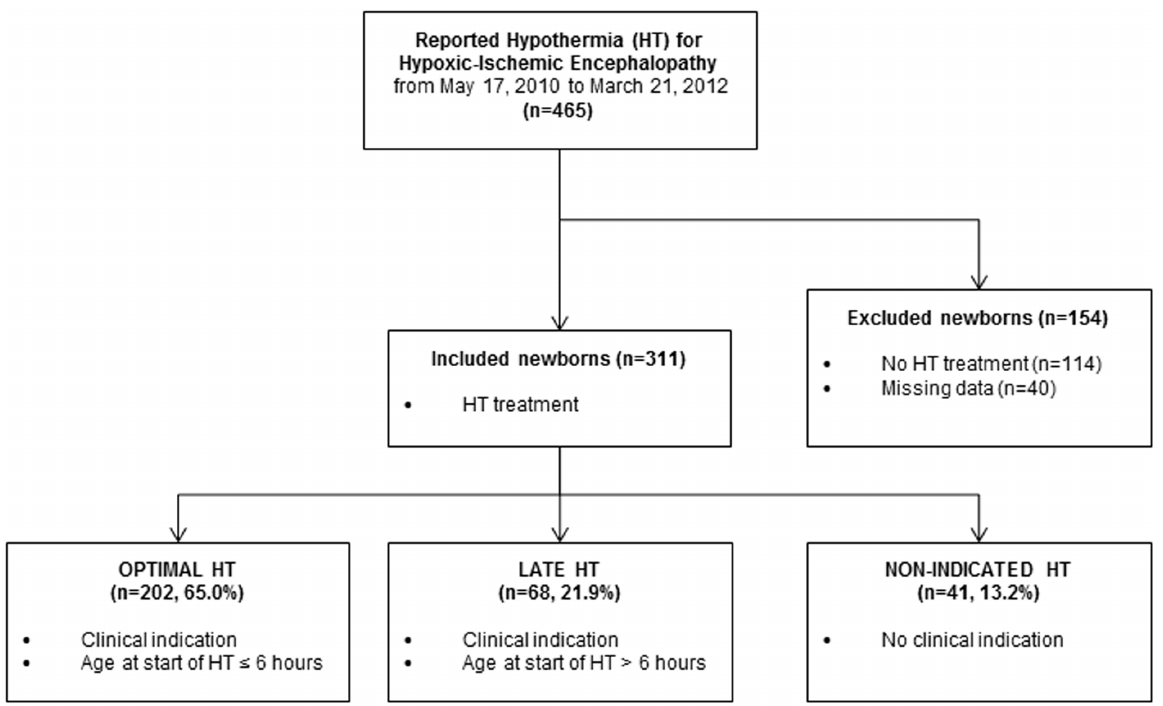
Figure 1. Flow chart of the population study.